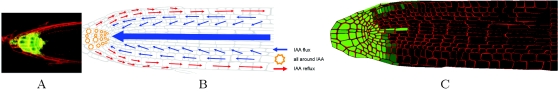

Flux-based polarization model of the root meristem.
Flux-based polarization hypothesis is compatible with the maintenance of an auxin maximum and with the general organization of PIN at the root tip. (A) shows the existence of a stable auxin maximum at the root tip as evidenced by the DR5:GFP marker (Ottenschlager 2003; Grieneisen 2007). At the shoot apex, the general organization of the different PIN transporters in the different tissues suggests a flux going downward via the vascular tissues and than spreading out over superficial layers “like a fountain” (B). (C) shows a digitized root apex based on a real optical section from an Arabidopsis root (not shown, image taken by Tom Beeckman). Similarly to PIN maps at the shoot apex, the polarity of PIN was recorded in each cell. This PIN map was used as an initial condition for the simulation. The cellular system was provided with a fixed global quantity of auxin initially divided equally over the tissue. In addition, two border cells of the epidermis were chosen as auxin sinks, to comply with the biological assumption that a fraction of auxin is evacuated from the root tip along the epidermis (Swarup 2005). Auxin arriving in these sink cells is completely depleted at each simulation step. In addition, a permanent auxin source was added on the border of the central vascular system providing auxin in a constant fashion, in accordance to biological auxin source localization in the vascular bundle. Simulations revealed that transporter dynamics based on flux-based polarization are sufficient to enable and maintain auxin accumulation in the collumella and quiescent centre (C), as observed in (A). Additionally, realistic transporter distribution profile was maintained by the flux-based polarization mechanism.